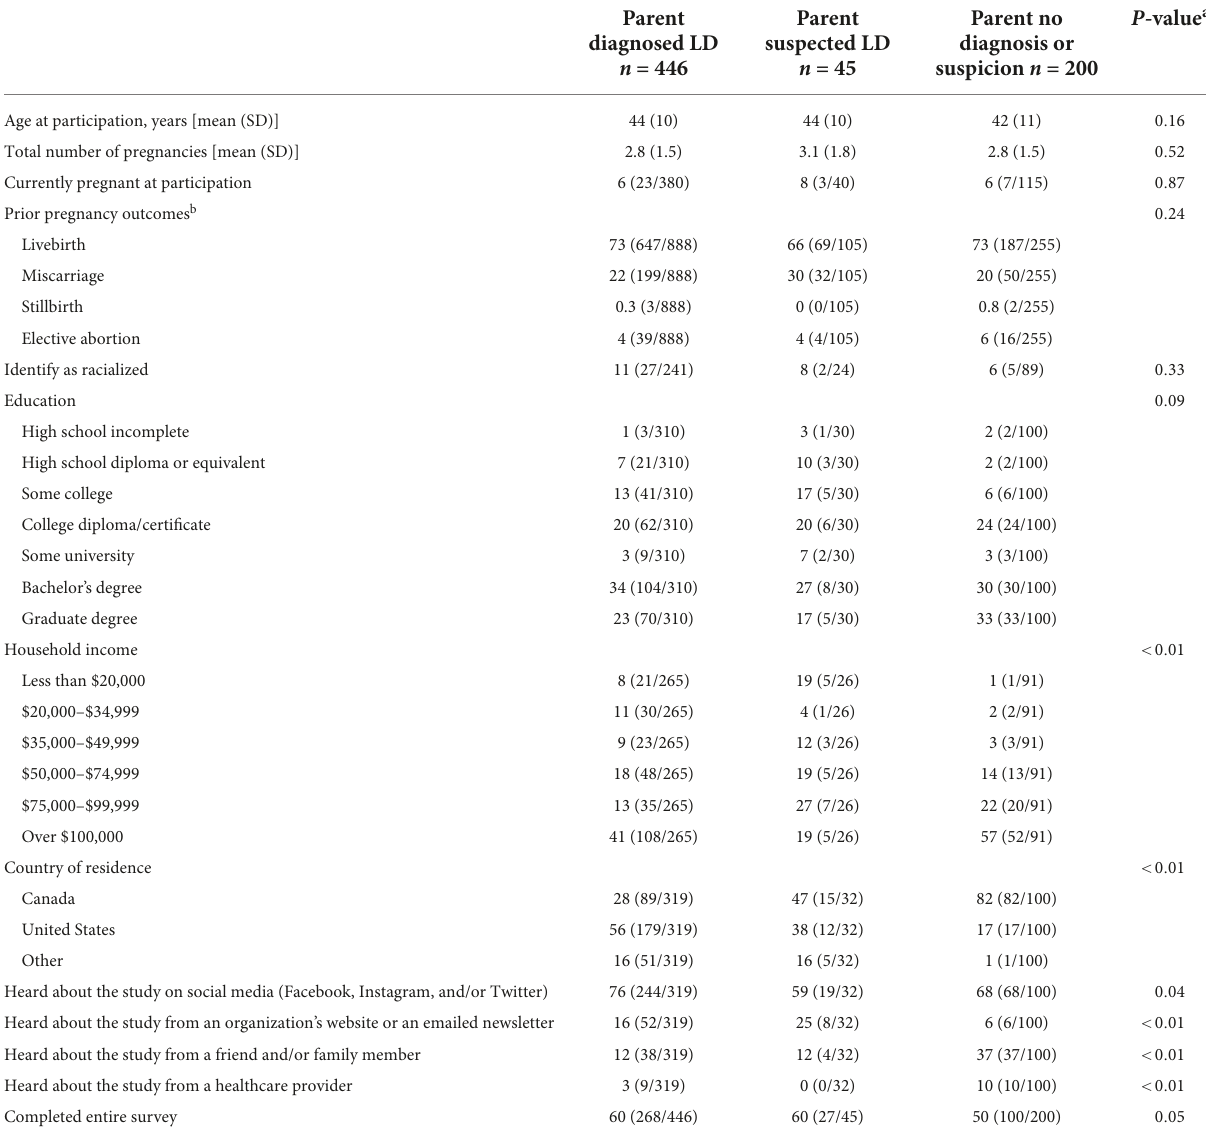
TABLE 1 Participant/birthing parent